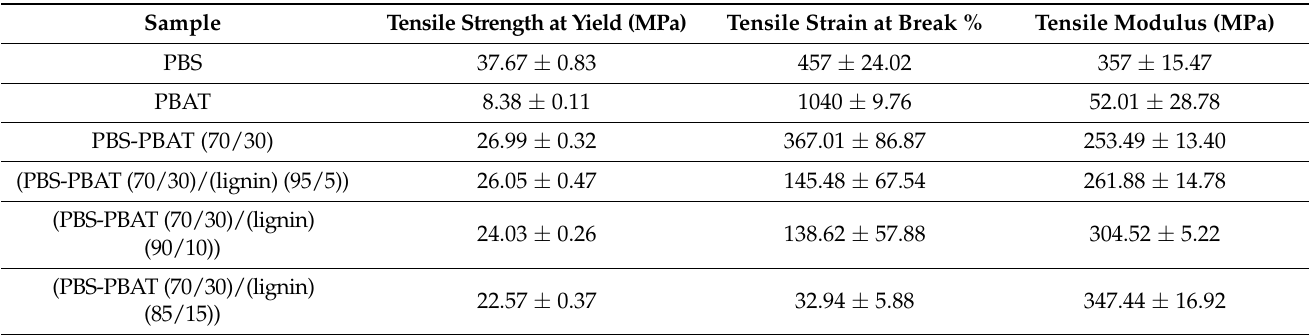
Table 3. Tensile properties of hybrid composites with different lignin